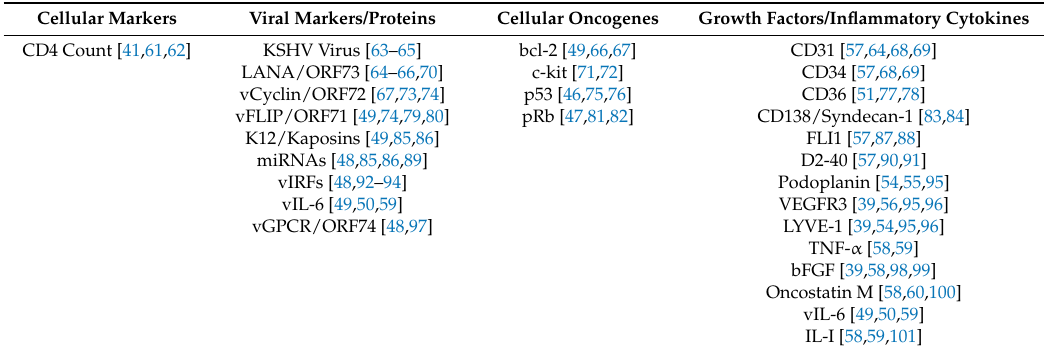
Figure 1. Summary of significant cancer diagnosis markers detected in Kaposi’s sarcoma-associated herpesvirus (KSHV)-associated neoplasms. These biomarkers can be categorized into virus specific markers (KSHV genome or specific proteins), cellular markers, cellular oncogenes, and inflammatory cytokines/growth factors. Table 1. Summary of current biomarkers in acquired immune deficiency syndrome (AIDS)-associated KS.